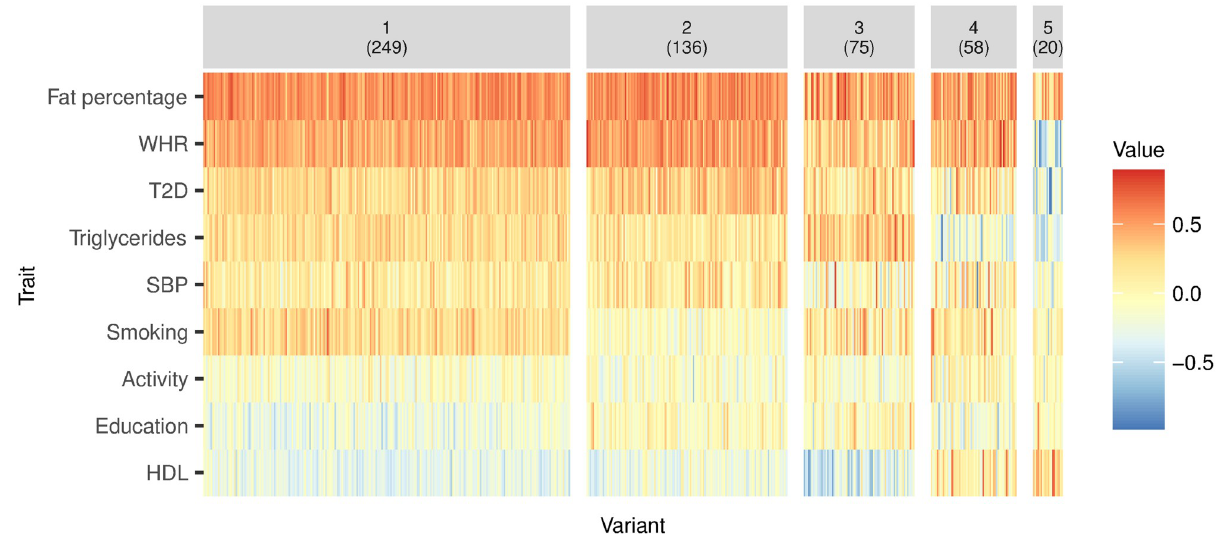
Fig 3. Heat map showing the association estimates of the BMI associated genetic variants with each trait by cluster. The association estimates were first standardised by dividing by their standard errors, then normalised so that the vectors of association estimates for each variant have magnitude one. Thus, the values shown represent the proportional association estimates for each genetic variant on the set of traits. The value in parentheses underneath each cluster label is the number of variants in the respective cluster.